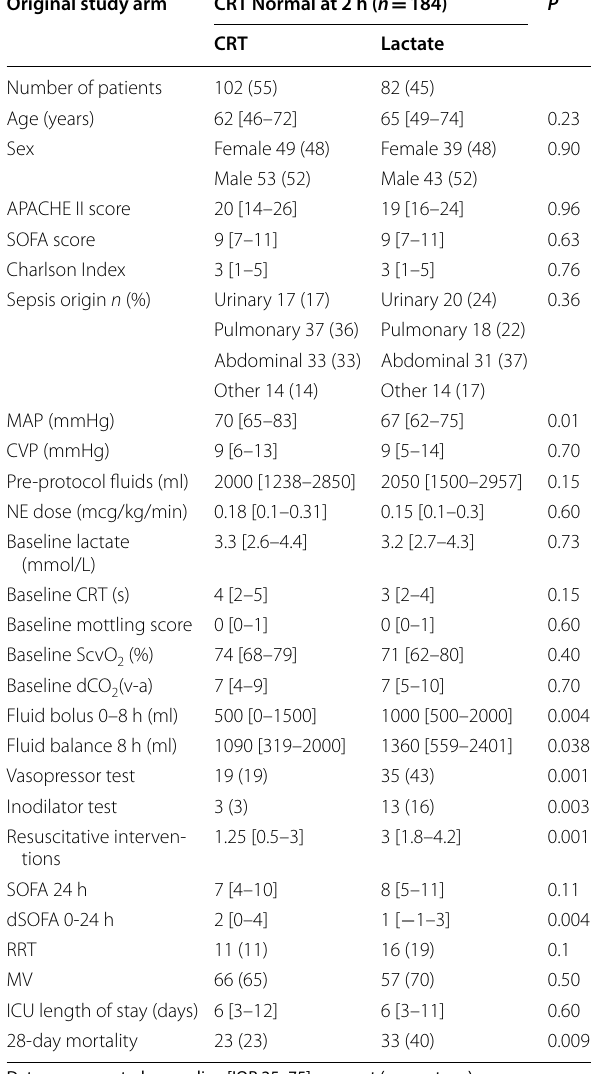
Table 2 Clinical and interventions comparison between CRT responders at T2, according to study